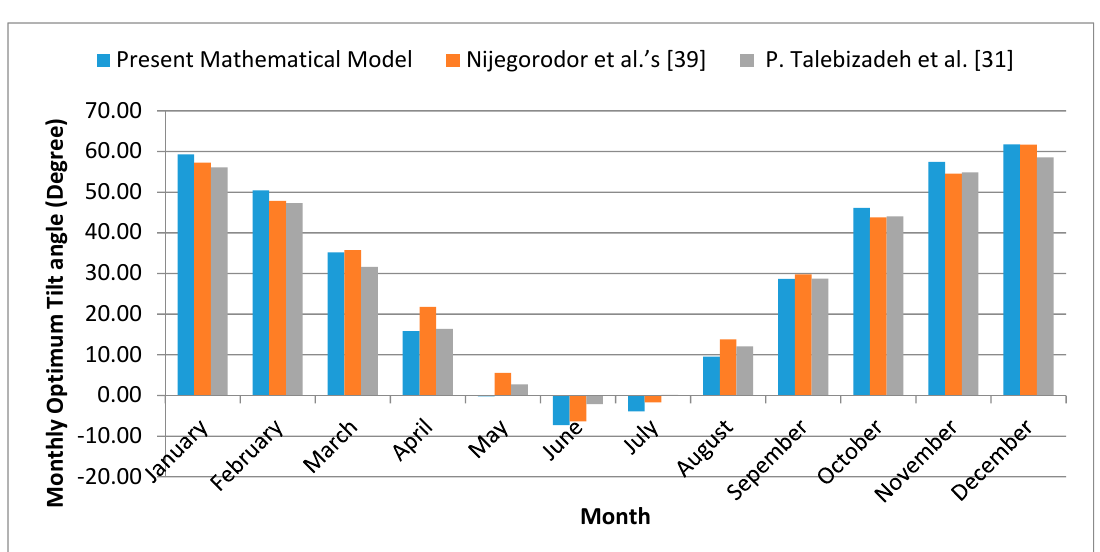
Figure 13. Comparison of monthly and yearly tilt angles for Jerusalem based on Nijegorodor et al [39]. and P. Talebizadeh et al [31], with values calculated in the present mathematical model.